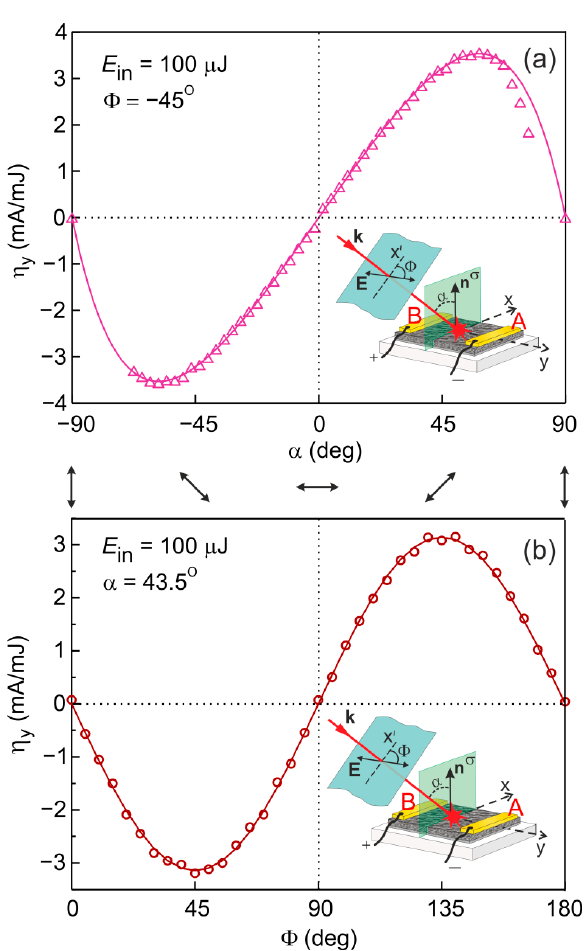
Figure 2. The light to transverse photocurrent conversion coefficient η y as a function of ( a ) the incidence angle α at the polarization azimuth Φ = − 45 ° (triangles correspond to the experimental data while the solid line represents the result of the fitting with equation η y = 8.37sin2 α / ( 0.87cos α + 1 ) 2 ) and ( b ) the polarization azimuth Φ at α = 43.5 ° (circles denote experimental data, the solid curve represents the fitting with the equation η y = − 3.1sin2 Φ ; the orientations of the plane of polarization of the incident radiation are shown at the top). The insets show the sketches of the experimental setups.